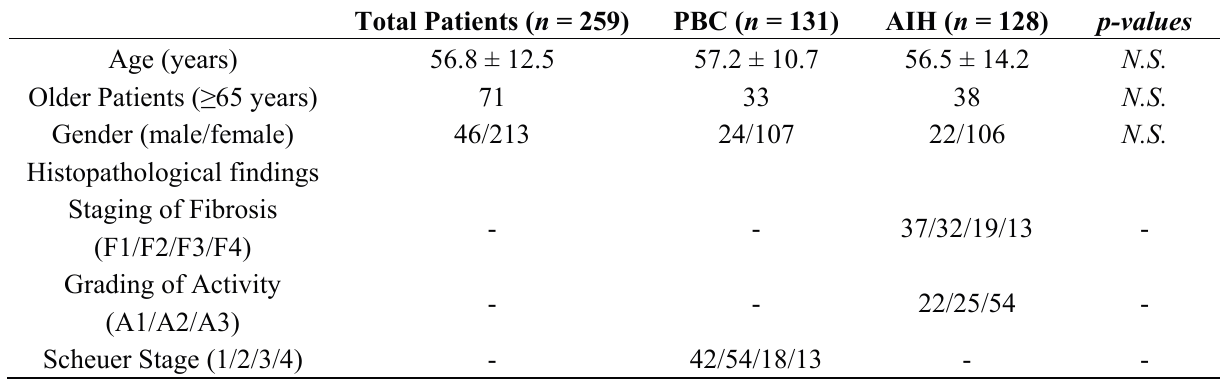
Table 1. Characteristics of patients with autoimmune liver diseases in the present